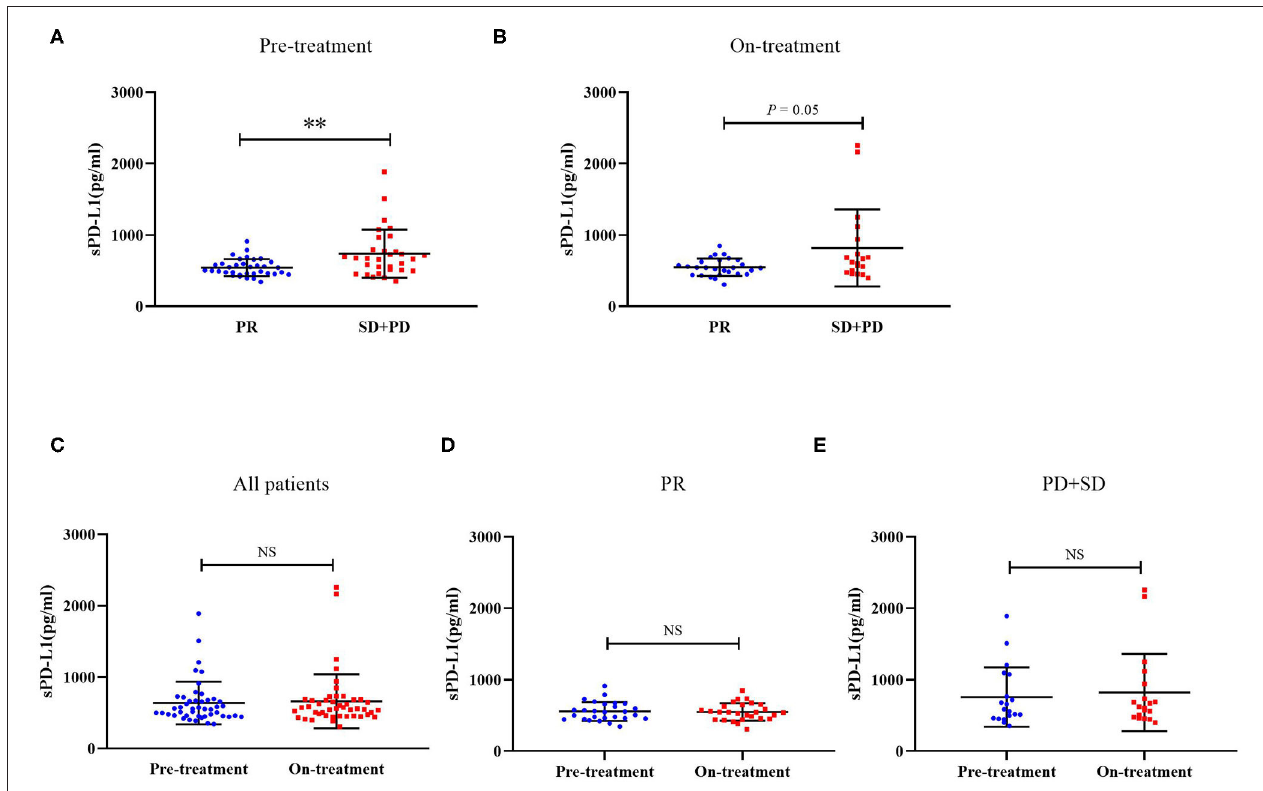
FIGURE 1 | (A) Distribution of sPD-L1 concentrations prior to the initiation of EGFR-TKI treatment according to therapeutic responses. (B) Distribution of sPD-L1 concentrations 1 month after initiating EGFR-TKI treatment according to therapeutic responses. (C) sPD-L1 concentrations at pre-treatment and on-treatment in whole patient group. (D) sPD-L1 concentrations at pre-treatment and on-treatment in patients with PR. (E) sPD-L1 concentrations at pre-treatment and on-treatment in patients with SD or PD (Results are presented as mean ± SD. ** P < 0.01; NS, Not